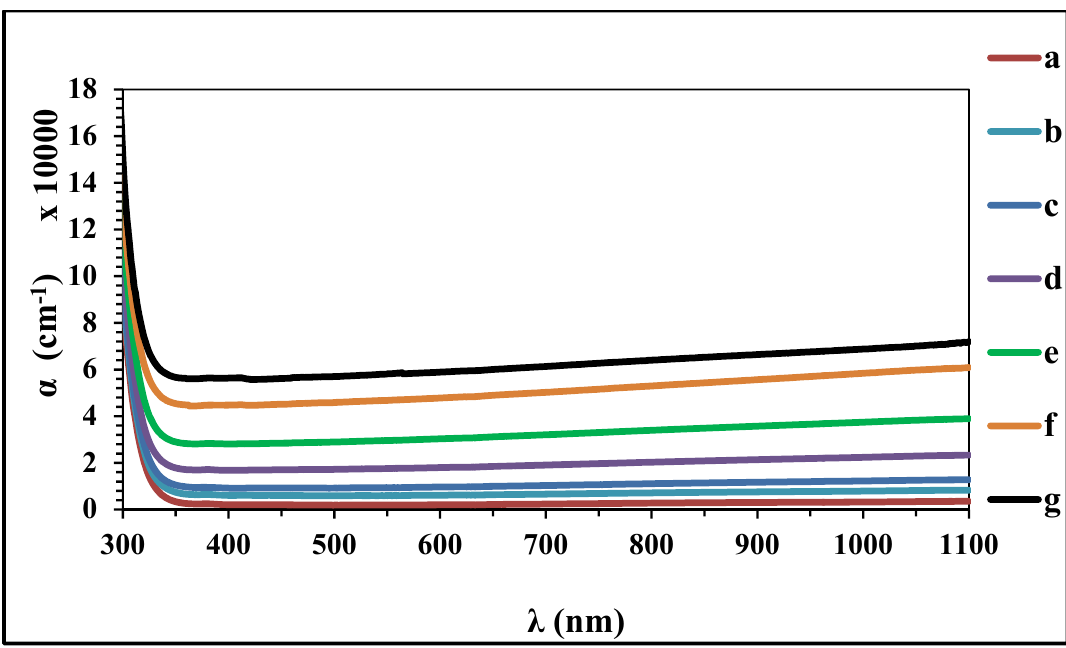
Fig. 5: The absorption coefficient for solid films of PVA\CuI composites with different concentrations of CuI. (a) 0